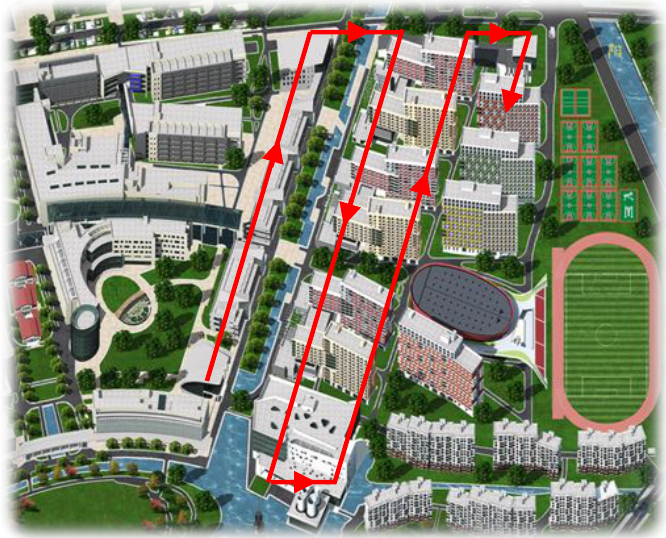
Figure 1. A UAV’s flying trajectory over a campus. A down-looking camera is equipped on